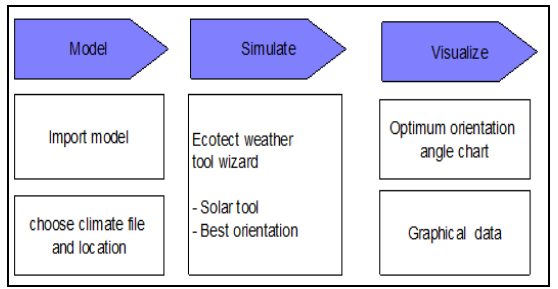
Figure 4. Solar absorption analysis